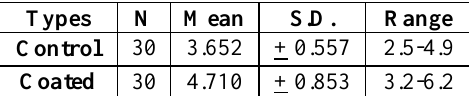
Table 5: Descriptive analysis of NBFP of CaCO 3 coated and uncoated groups after 6 weeks of healing period